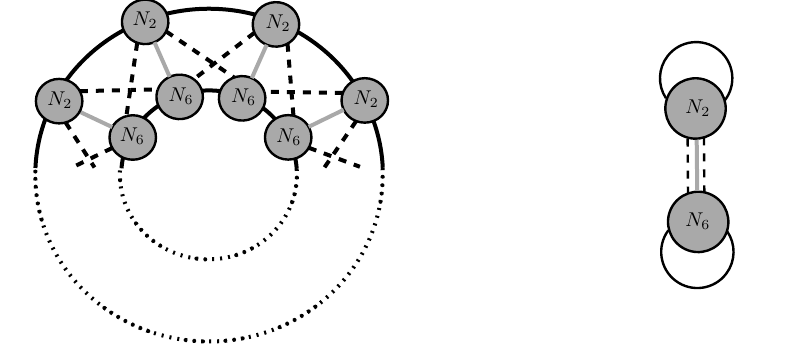
Figure 3 . Left: Generic quiver (cid:12)eld theory whose IR limit is holographic dual to the AdS 3 solutions with I = S 1 . Right: Quiver (cid:12)eld theory for M = 1. In the right quiver, the (0,4) hypermultiplets combine with two (0,2) Fermi multiplets to produce (4,4) hypermultiplets. Supersymmetry is thus enhanced to